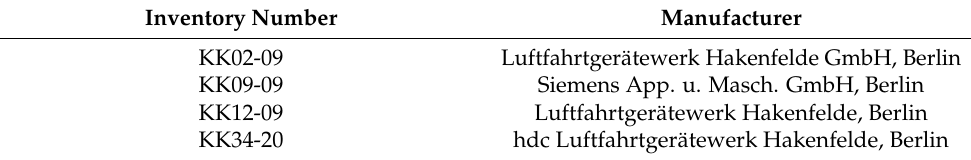
Table 3. Tracing the gyroscope manufacturers [45].